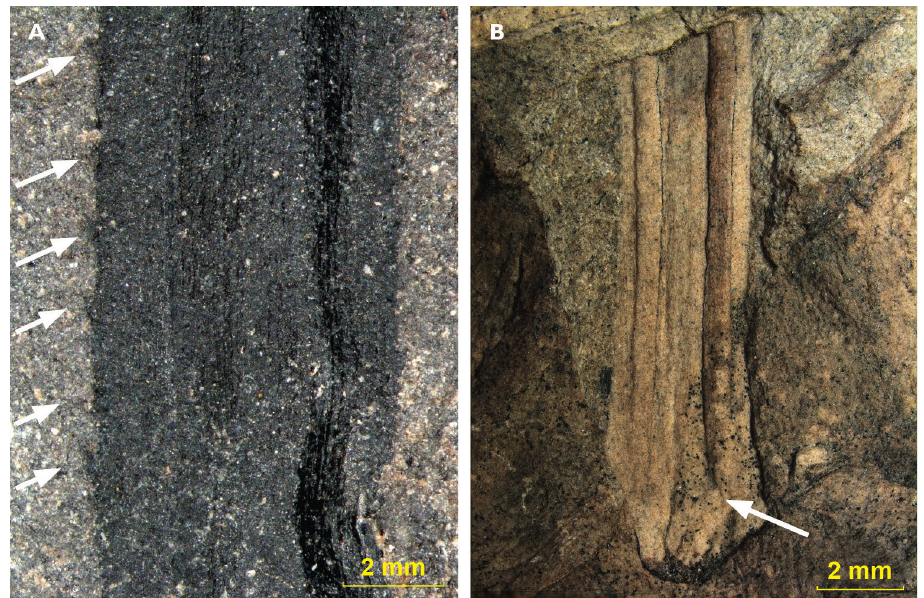
Figure 8. Leaf details: A Marginal microdenticulation, sample 34, Ronchamp (arrows indicate micro- denticulation). B. Basal part of the leaf showing that the two stomatal furrows do not run all the way down in the leaf base, sample 1529, Mt Pelé (arrow indicates origin of